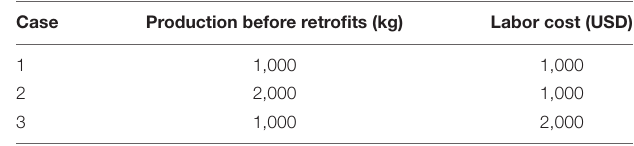
TABLE 1 | Cases used in the experimental